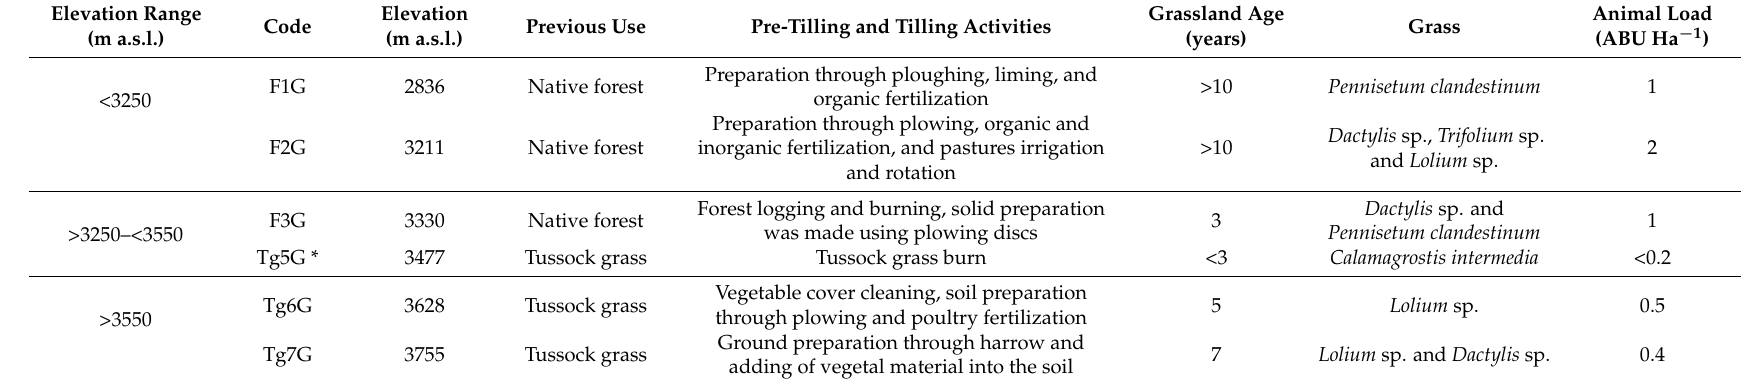
Table 2. General description of the grazing